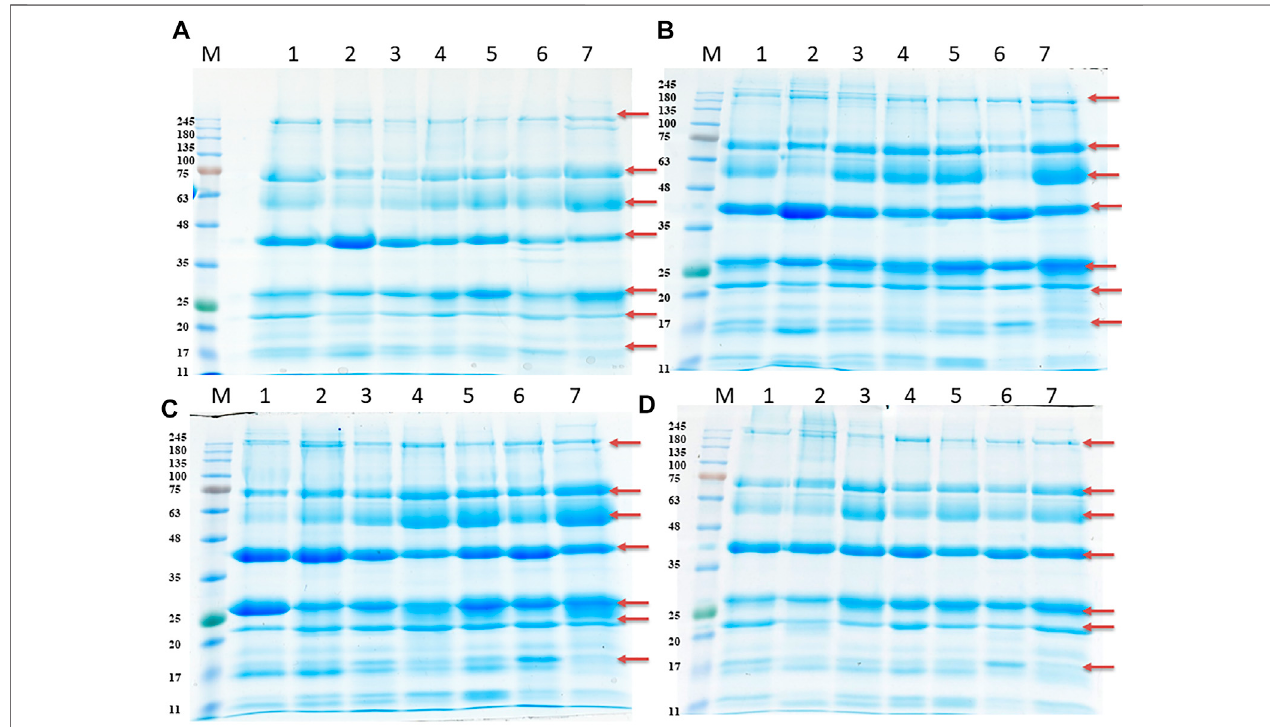
FIGURE7| SDS-PAGEofsalivaryproteinsduringproestrus(PE) (A) ,estrus(E) (B), metestrus(ME) (C), anddiestrus(DE) (D) stagesofthebuffaloestrouscycle.M, protein molecular markers; Lane 1-7 contains 25 μ g protein from 7 individual buffaloes. Arrow indicates presence of 7 major bands.